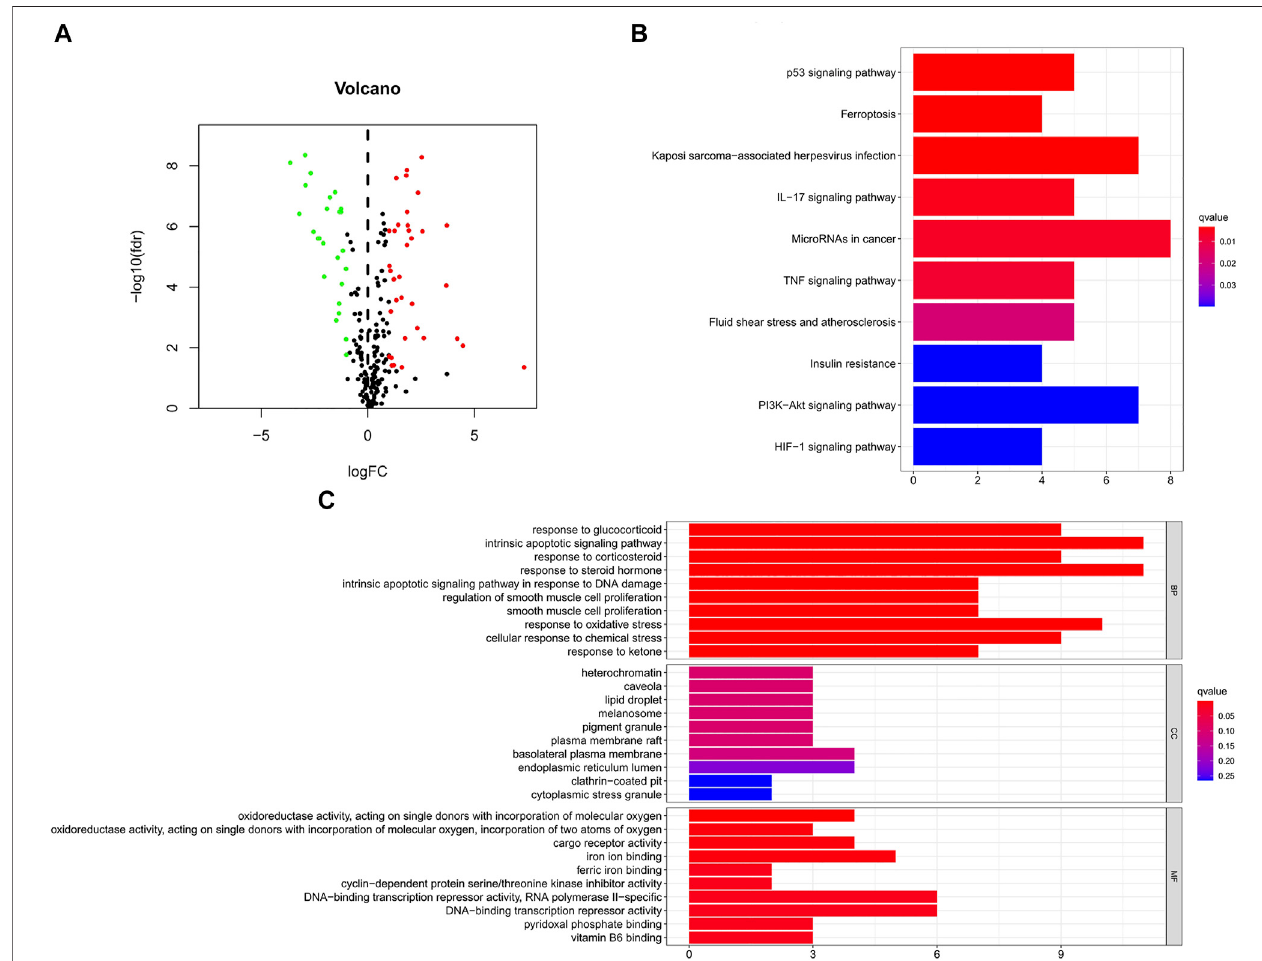
FIGURE2| GOand KEGG analysesofferroptosis-related DEGsin cancer and adjacent tissues. (A) Volcano plot of259ferroptosis-related genesin BC. Red dots represent up-regulated genes and green dots represent down-regulated genes. (B) KEGG analysis of ferroptosis-related DEGs. (C) GO analysis of ferroptosis-related DEGs. GO, Gene Ontology; KEGG, Kyoto Encyclopedia of Genes and Genomes; DEGs, differentially expressed genes; FC, fold change; fdr, false discovery rate; BP, biological process; CC, cellular components; MF, molecular function.